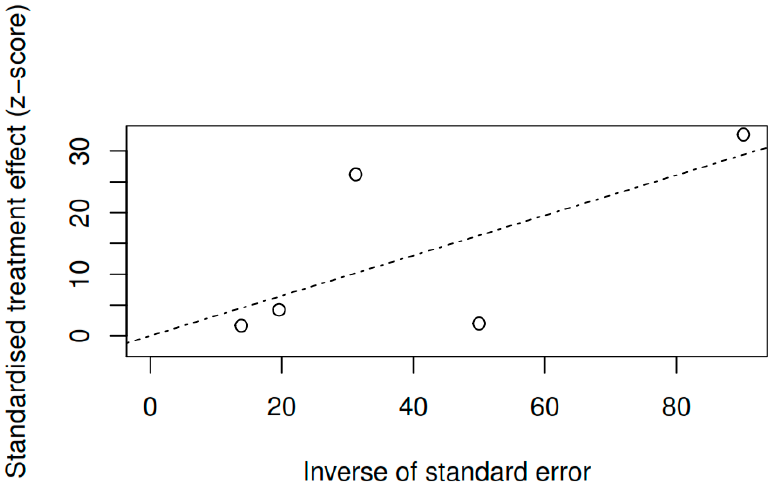
Figure 12. Radial adjustment chart of the random effects model for the variable overall symptomatology (pretest–posttest).